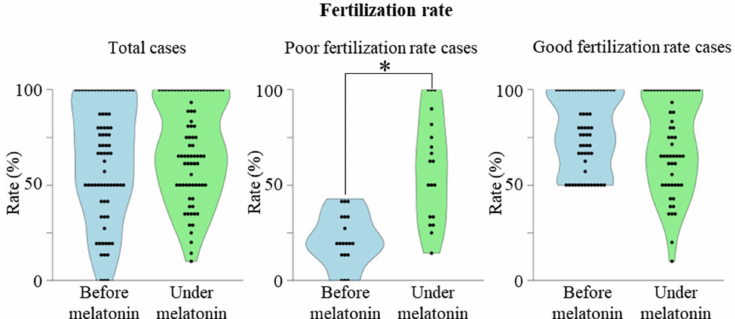
Figure 1. Association between previous fertilization rate and the effect of melatonin. Effect of melatonin on the fertilization rate. The fertilization rates in the cycles before and under melatonin treatment are shown in the violin plot. Left graph: Effect of melatonin in total 75 cases. Middle graph: Effect of melatonin in 19 cases whose fertilization rate before melatonin treatment was less than 50% (Poor fertilization rate cases). Right graph: Effect of melatonin in 56 cases whose fertilization rate before melatonin treatment was more than 50% (Good fertilization rate cases). * p < 0.01 vs. before